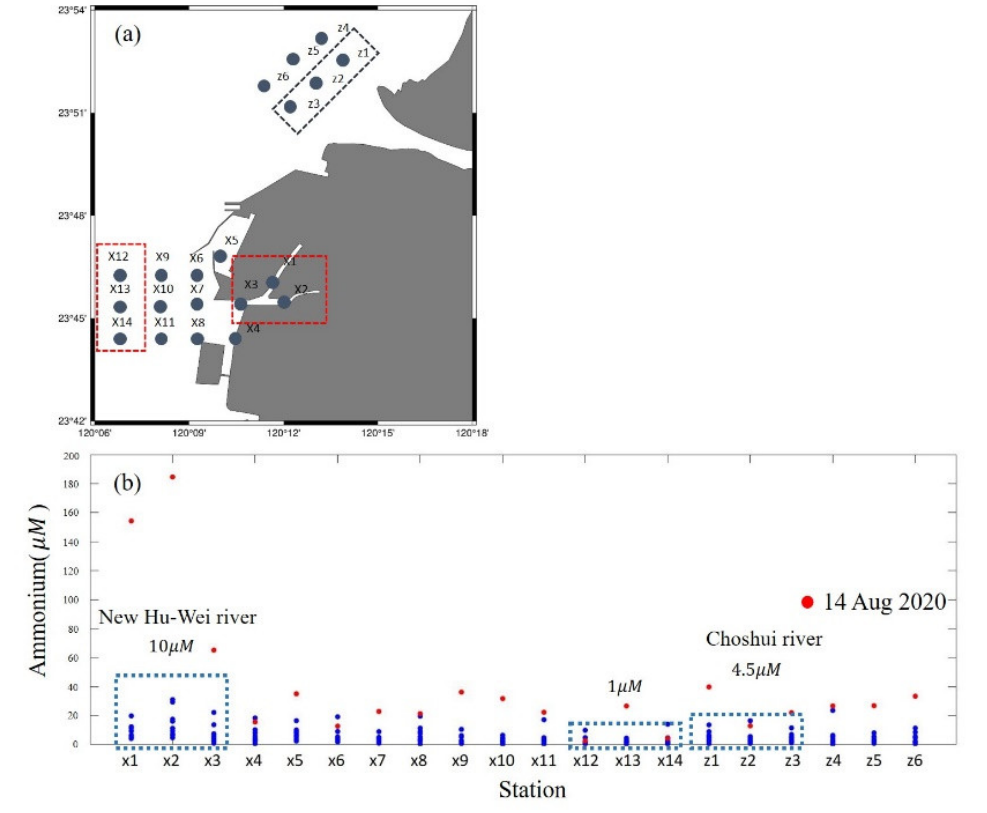
Figure 3. ( a ) Water quality was sampled at 14 stations (x1–x14) and 6 stations (z1–z6) around and offshore from the river’s estuary. ( b ) Blue and red dots indicate the ammonium concentration revealed by water quality sampling stations for the general case and for a special case on 14 August 2020, respectively. Blue dashed frames cover three stations and denote the average ammonium concentration of three stations.